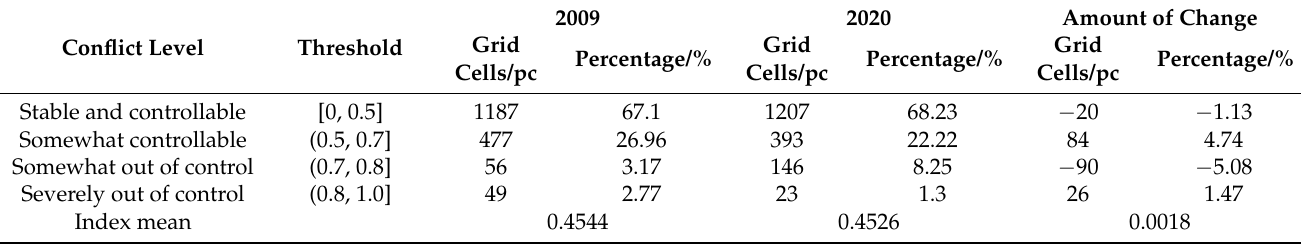
Table 2. Spatial conflict index (ESC) of Xintai from 2009 to 2020.